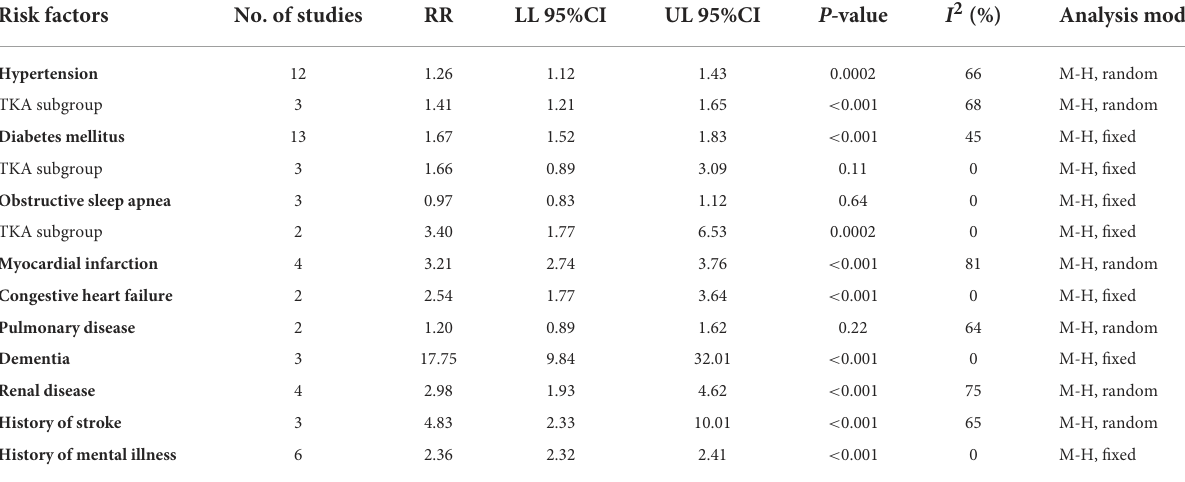
TABLE 4 The main outcomes of meta-analysis and subgroup analysis (comorbidities).